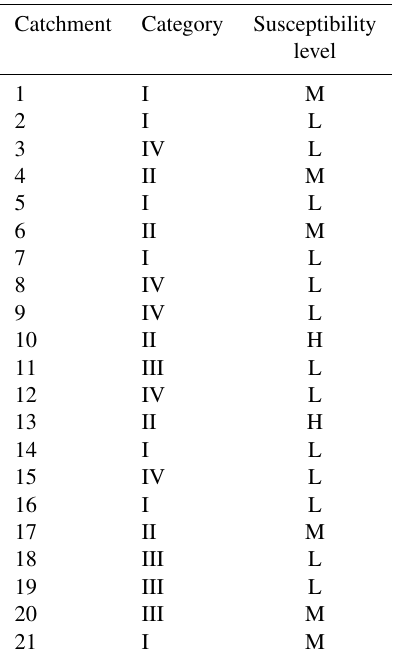
Table 16. The qualitative description and susceptibility class for each debris flow